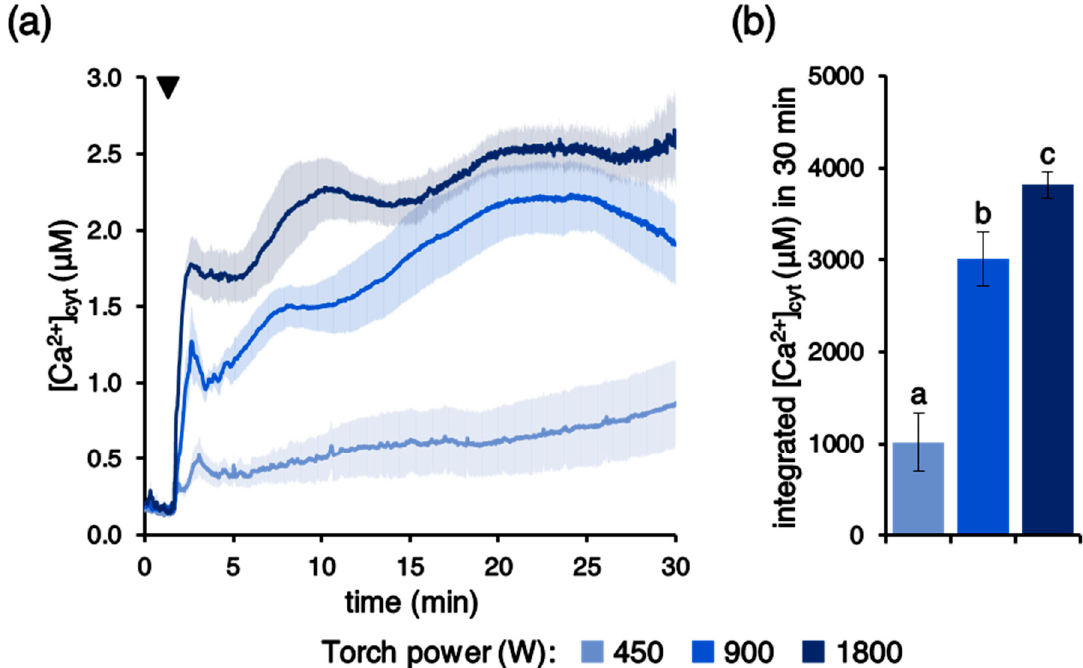
Figure 2. Dependence of the PAW-induced [Ca 2+ ] cyt elevation dynamics on the power of the plasma torch used to generate PAW. Ca 2+ measurement assays were conducted in aequorin-expressing Arabidopsis seedlings. Seedlings were challenged with 1:2 dilutions of different PAWs, obtained after 5 min exposure of deionized H 2 O to cold plasma generated under various torch #1 power conditions: 450 W (pale blue), 900 W (blue), and 1800 W (dark blue). ( a ) Data are the means (solid lines) ± SE (shading) of six seedlings derived from three independent growth replicates. The arrowhead indicates the time of stimulus application (at 100 s); ( b ) statistical analyses of integrated [Ca 2+ ] cyt dynamics over 30 min. Bars labelled with different letters differ significantly ( p < 0.05, Student’s t